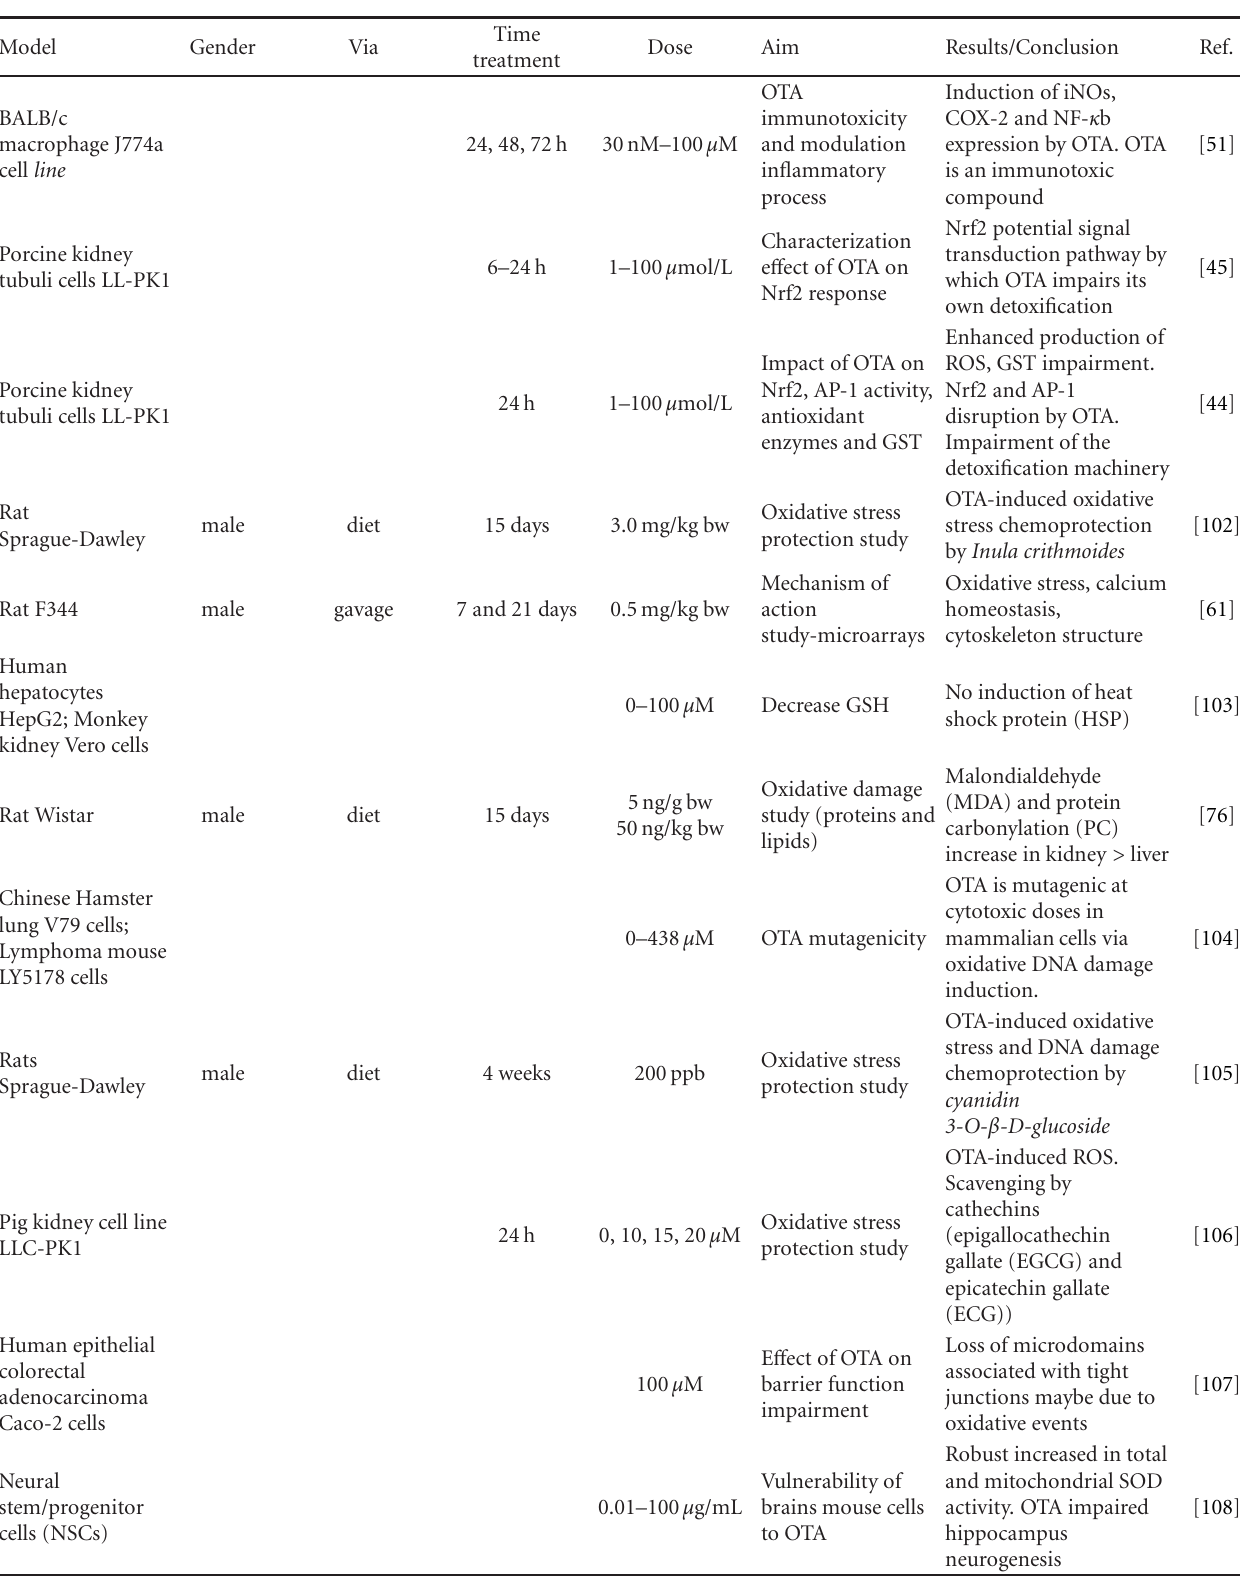
Table 1: OTA oxidative stress-related